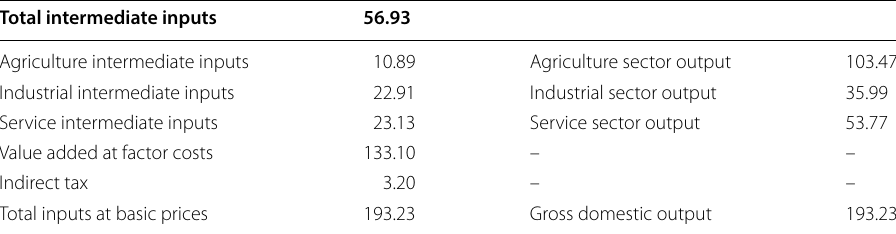
Table 8 Input–output accounting for the Oromia economy in billion ETB. Source: author’s computation using GAMS